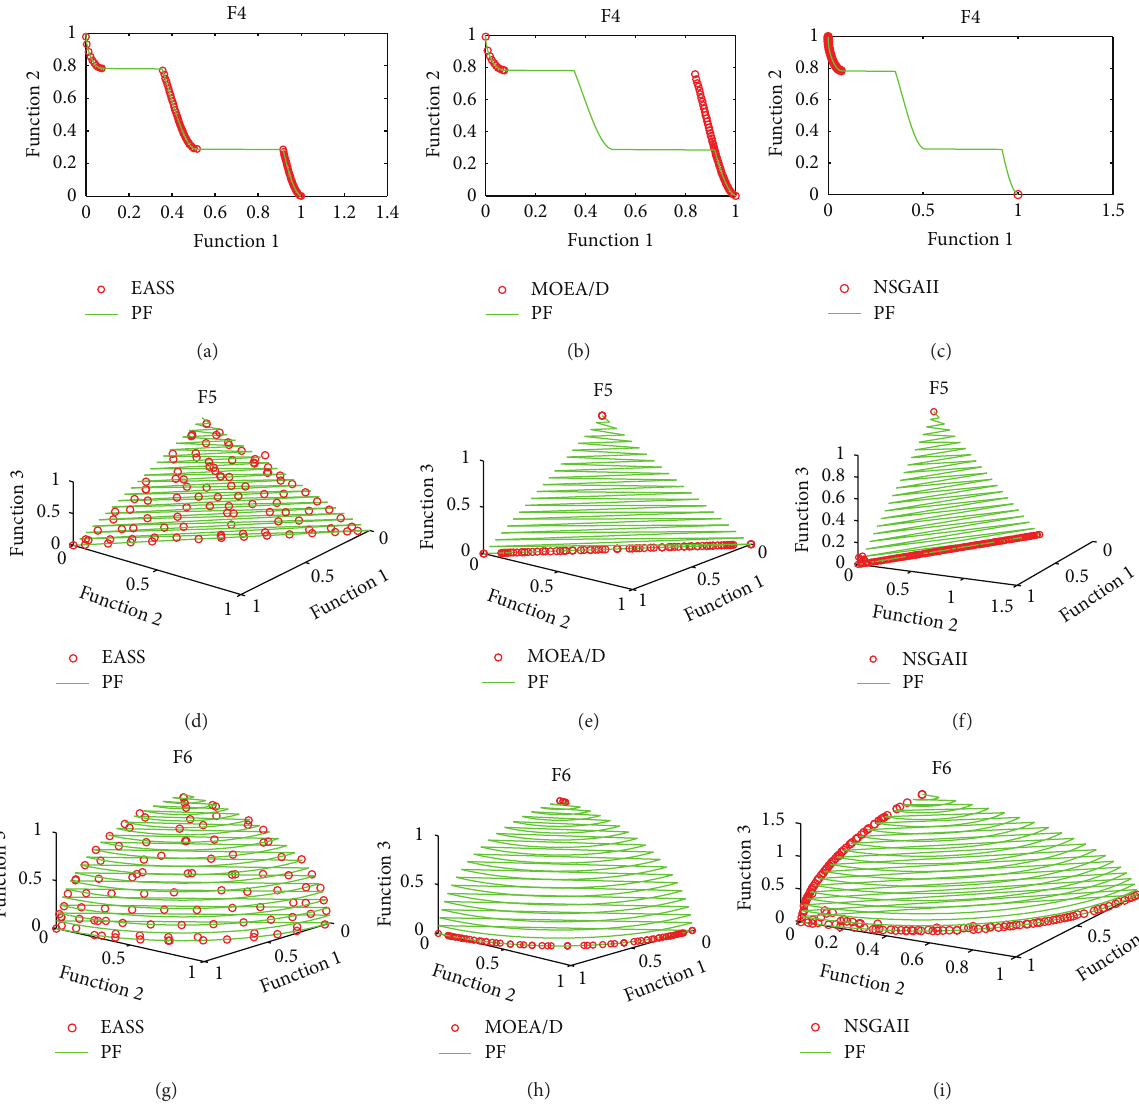
Figure 2: Solutions obtained by EASS, MOEA/D, and NSGAII on